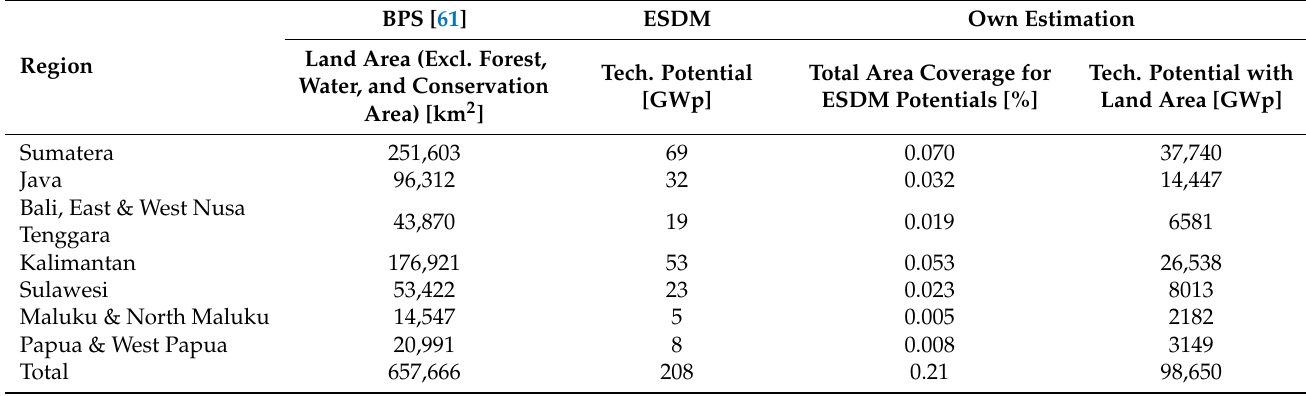
Table 4. The technical potential of solar PV based on ESDM [5,18,33] and own estimations for maximum land coverage excluding forest, water, and conservation